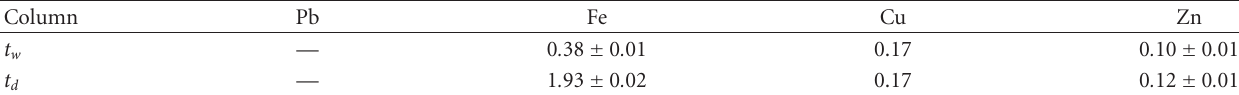
Table 2: Concentration (mg · mL − 1 ) of Pb, Fe, Cu and Zn in the leachate after the assay. Data: average ± standard deviation, n =